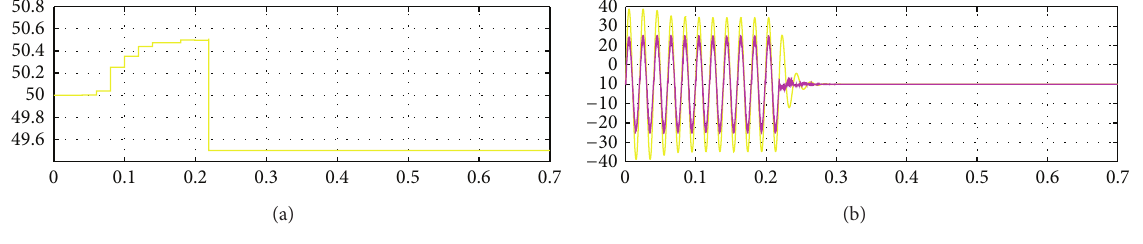
Figure 8: AFDPF the simulation waveforms.